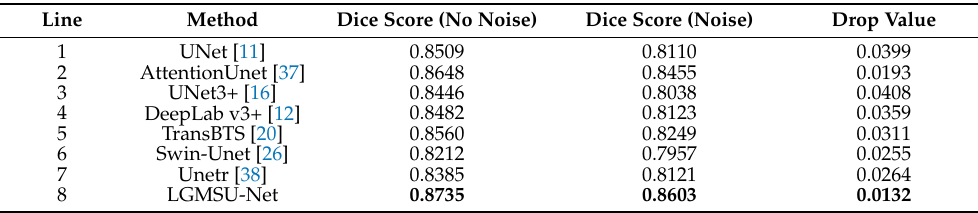
Table 5. Performance comparison of the proposed LGMSU-Net and seven state-of-the-art methods under the influence of noise. The best performance was shown in